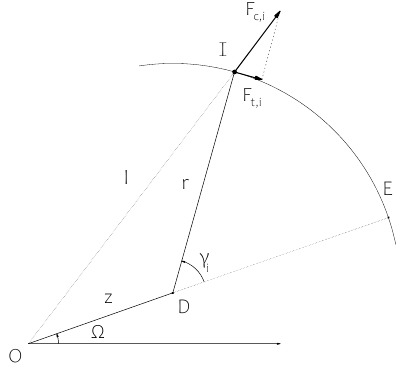
Figure 1. Fundamental sketch of a one-ball balancer with emphasis on forces acting on balancing mass